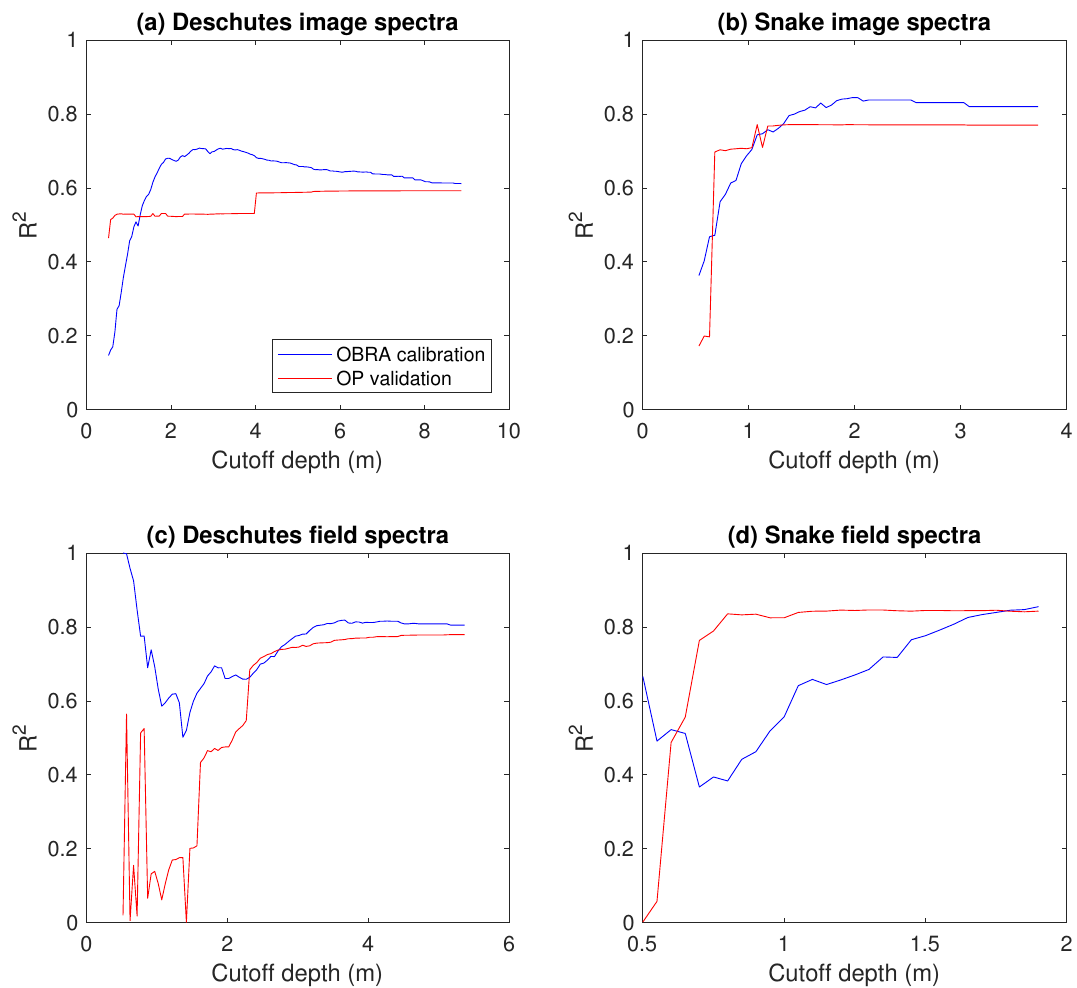
Figure 7. Summary of Optimal Band Ratio Analysis (OBRA) of Progressively Truncated Input Depths (OPTID) for each study site and data type. Both the OBRA R 2 for calibration and the observed vs. predicted (OP) R 2 for validation are plotted in each panel as blue and red lines,